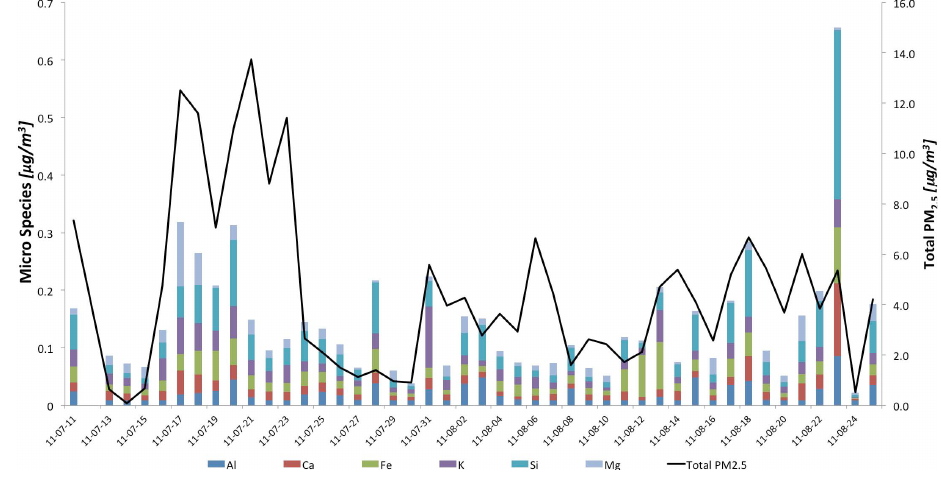
Fig. 6. Time series of total PM 2 . 5 mass and micro species concentration